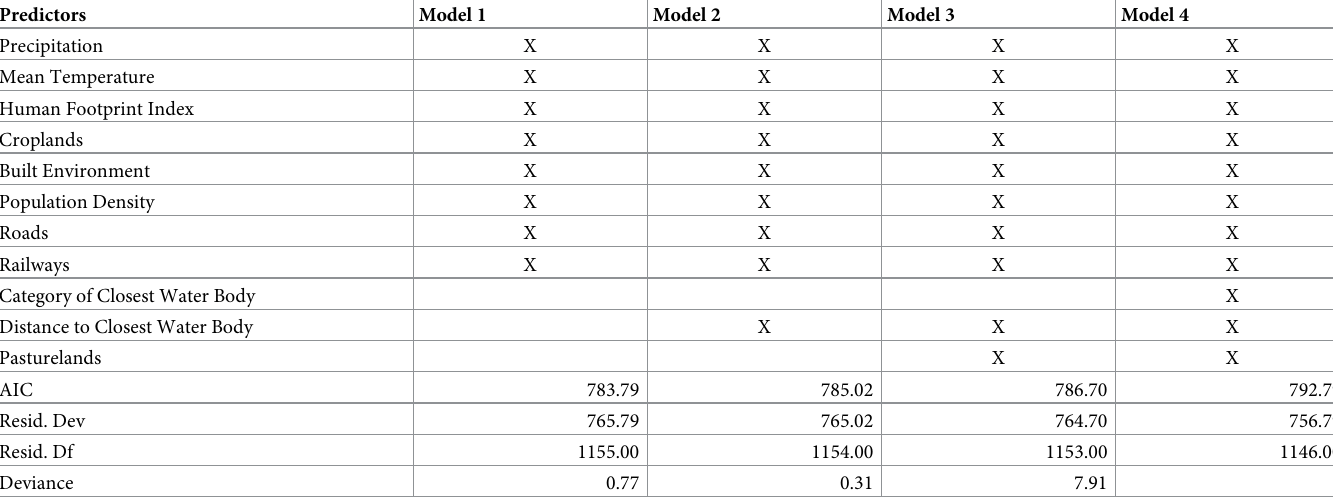
Table 3. Selection for the lowest AIC model for all time periods